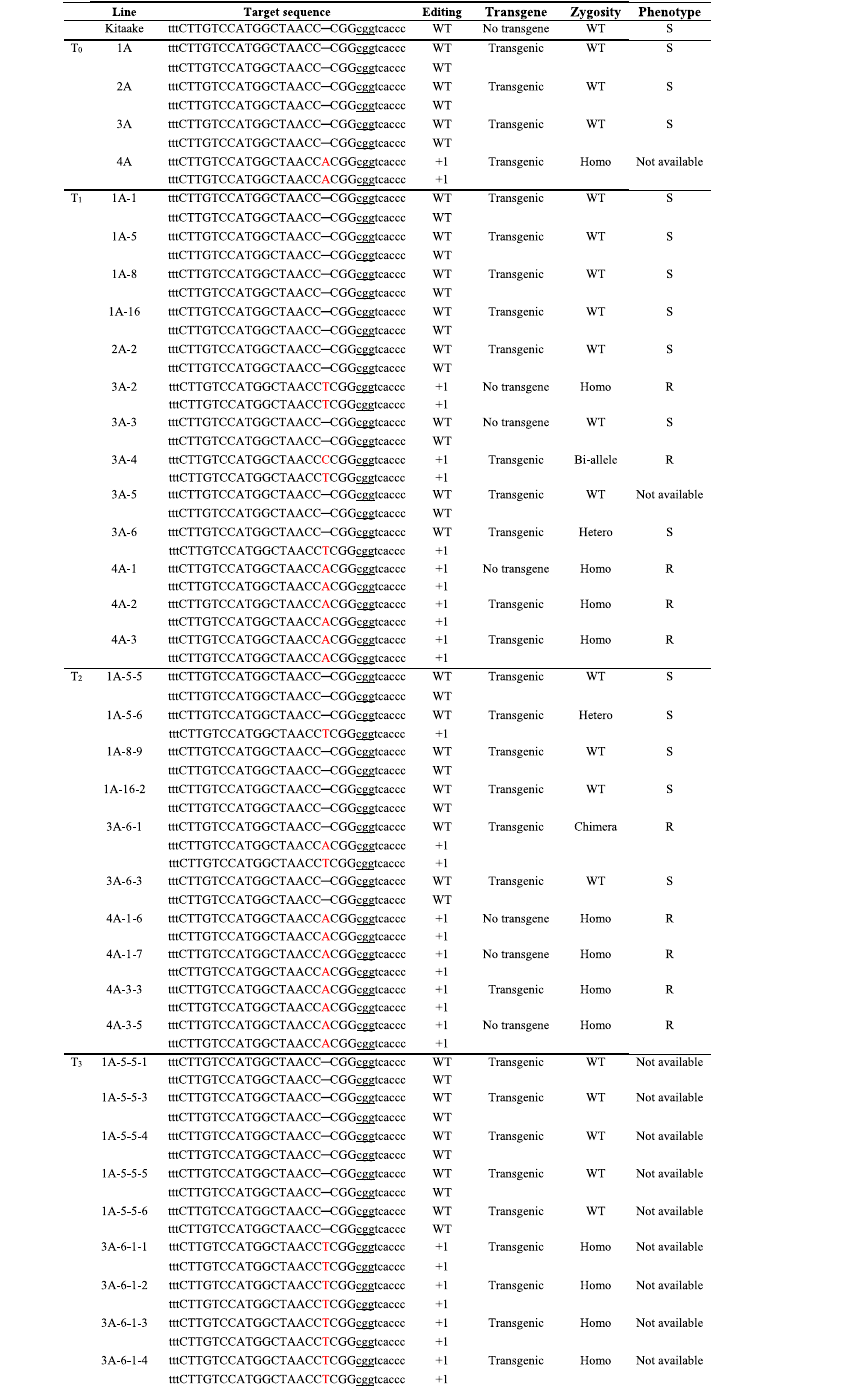
Table 1 Transmission and segregation of CRISPR/Cas9-mediated target mutagenesis from T 0 , T 1 , T 2 , and T 3 of the OsU6a xa13m /Kit transgenic plant. The recovered mutated alleles of the xa13/Os8N3 gene in the OsU6a xa13m /Kit transgenic plant are shown below the Kitaake sequence. Nucleotide sequences at the target sites are shown in black capital letters and black dashes. PAM motifs are underlined. Red capital letters indicate the inserted nucleotide. The genotype of the mutation is indicated at the right of each sequence. WT indicates the nucleotide sequences identical to the Os8N3 gene in Kitaake plants. “ + ” indicates the insertion of the indicated number of nucleotides. No transgene: PCR negative for Cas9 gene; Transgenic: PCR positive for Cas9 gene; S: susceptible to PXO99; R: resistant to PXO99; Not available: inoculation data are not